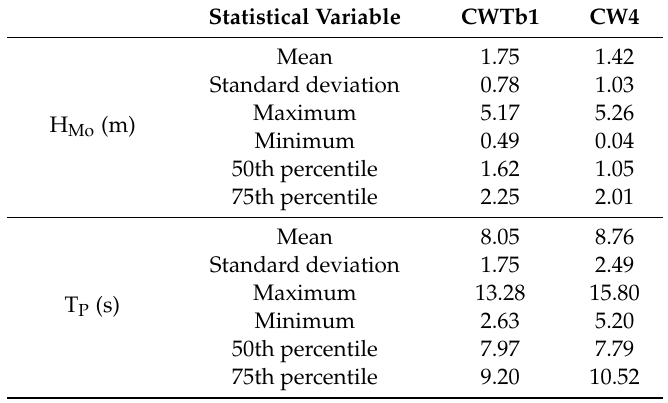
Table 2. Summary of statistical results of significant wave height and peak wave period from measurement locations CWTb1 and CW4. 1296 data points were included in the analysis for CWTb1 and 1342 data points for